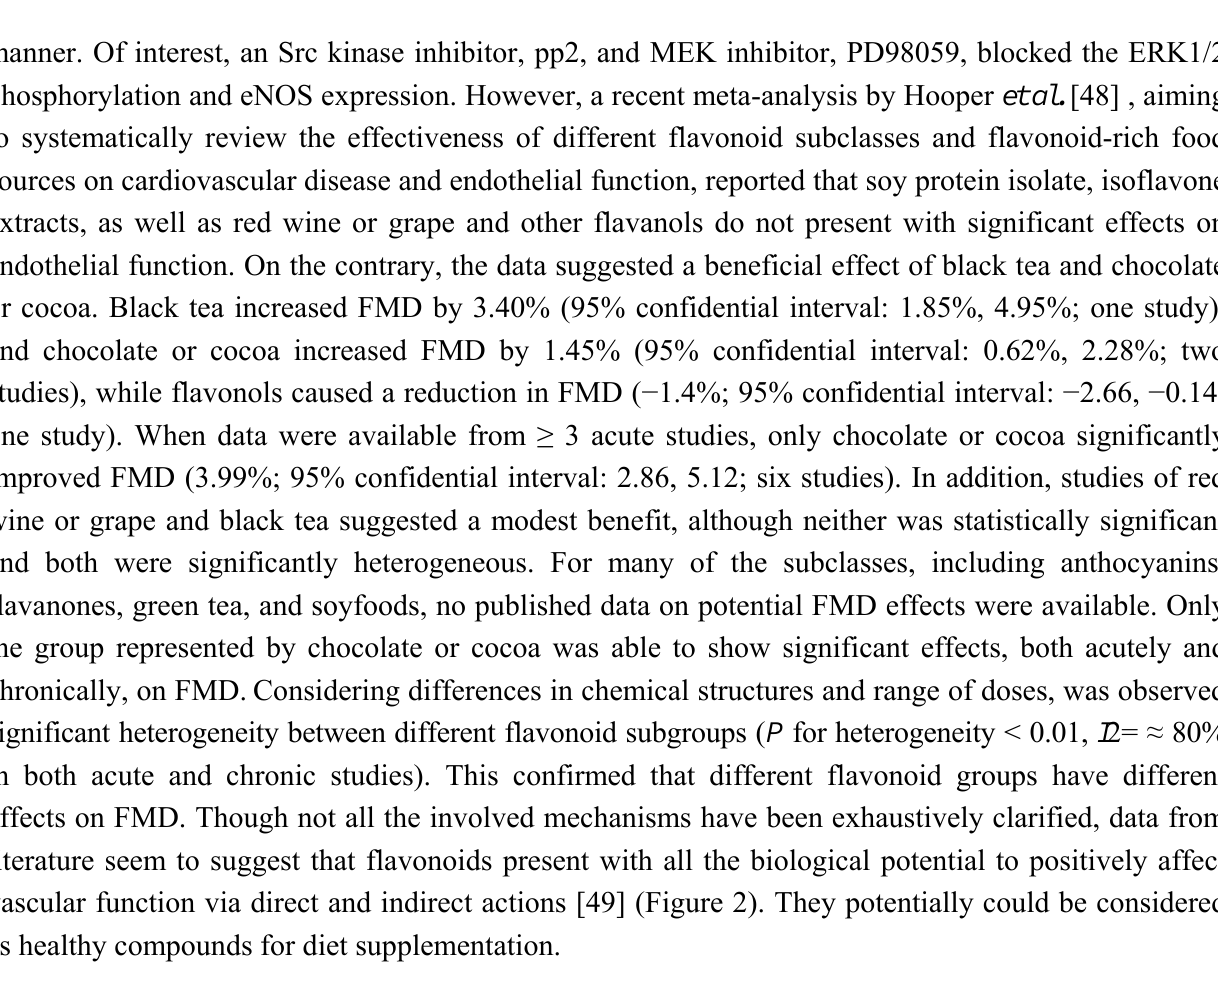
Figure 2. Potential effects of flavonoids on cardiovascular